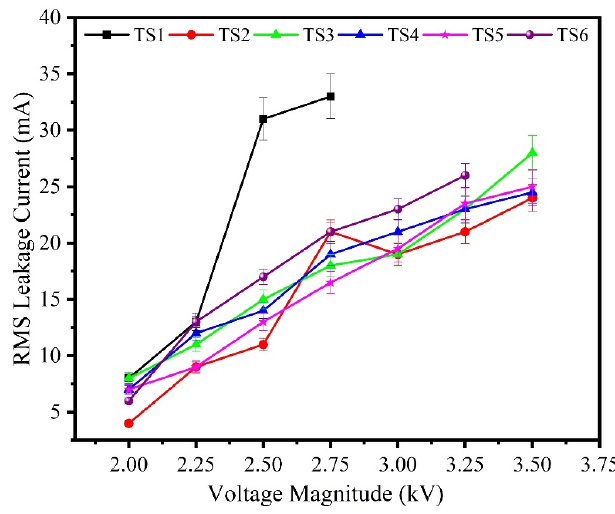
Figure 9. Leakage current of the aged samples.